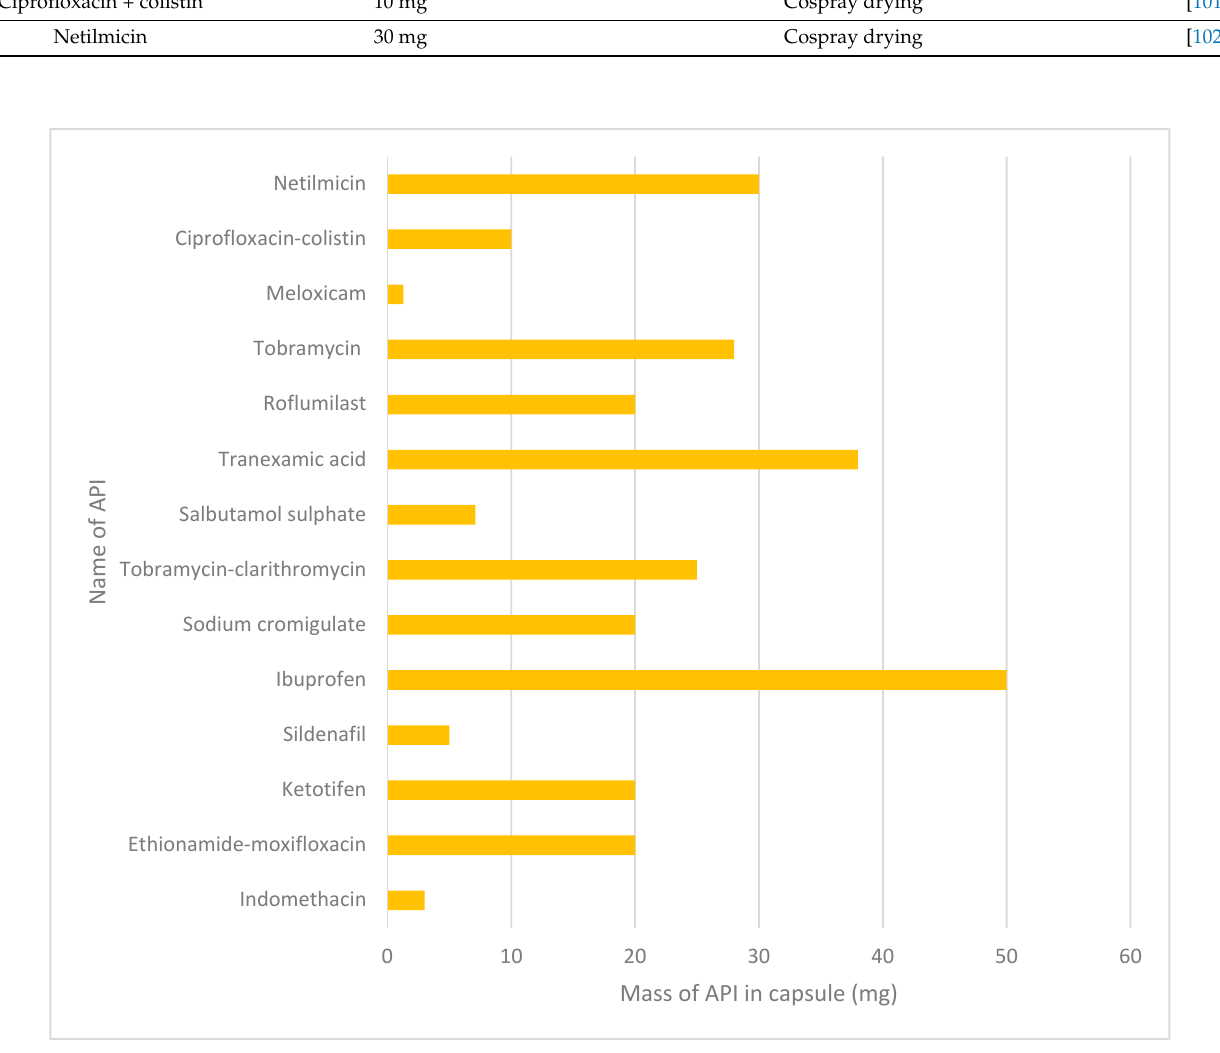
Figure 2. Bar graph for the weight of API in the capsule for each type of drug extracted from Table 6.